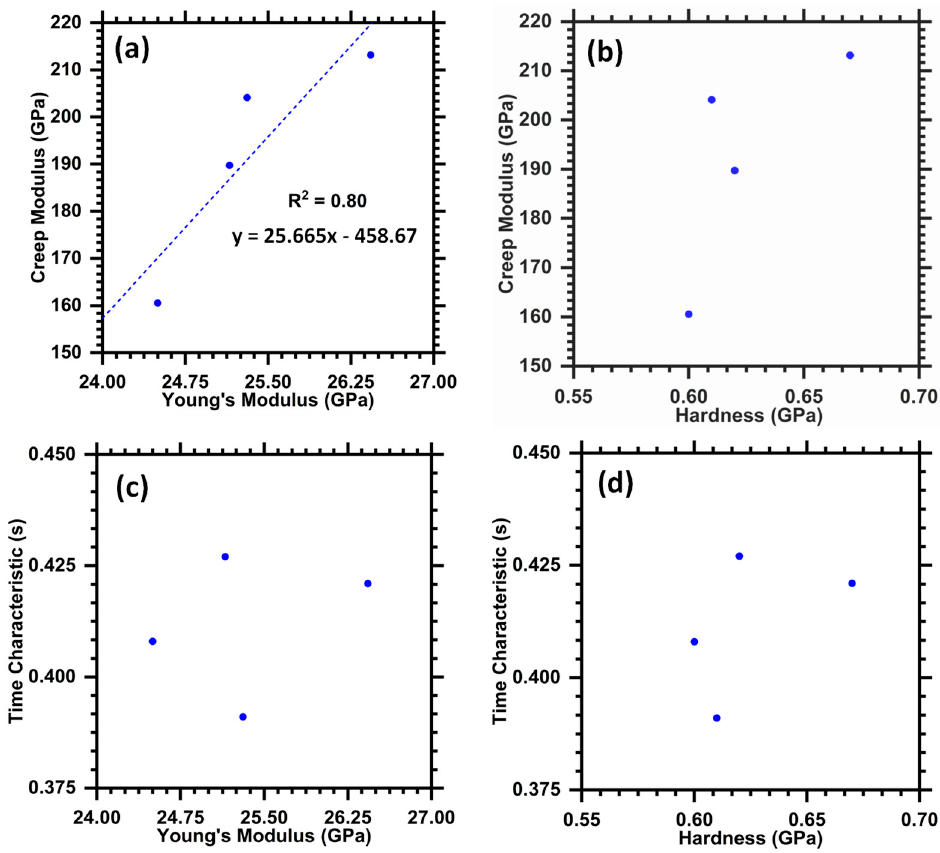
Figure 6. Variation in creep modulus with varying: ( a ) Young’s modulus, ( b ) Indentation hardness; variation in Time characteristics with varying: ( c ) Young’s modulus, ( d ) Indentation hardness.